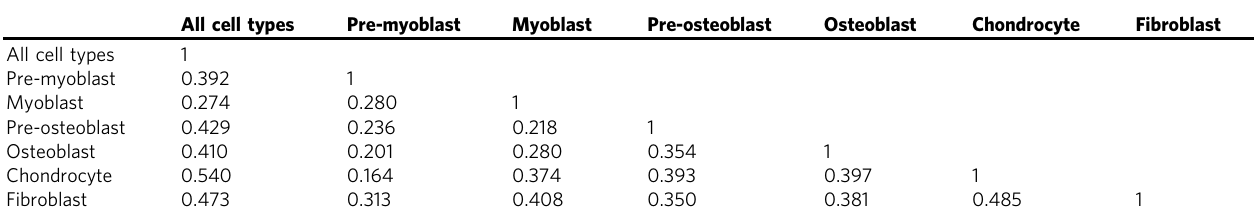
Table 1 Correlation coef fi cient of morphome features hierarchically clustered by cell type. All cell types Pre-myoblast Myoblast Pre-osteoblast Osteoblast Chondrocyte